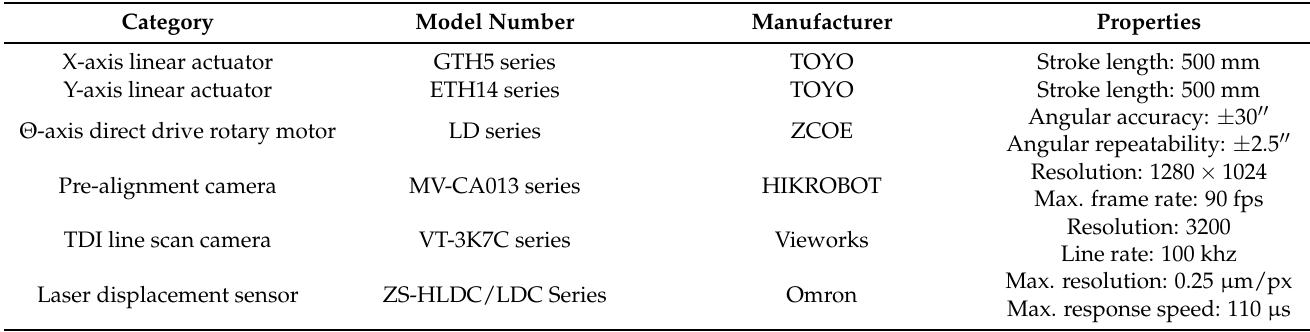
Figure 4. An overview of the automatic inspection system which mainly includes conveyor modules, pre-alignment modules, CCD inspection modules, carrier modules, and NG output modules. Tested LCD modules are first aligned by the misalignment correction algorithm, then the bump images are acquired by the CCD line scan camera, and finally, the conductive particles are detected. Table 1. Parameters and manufacturers of major modules in the inspection